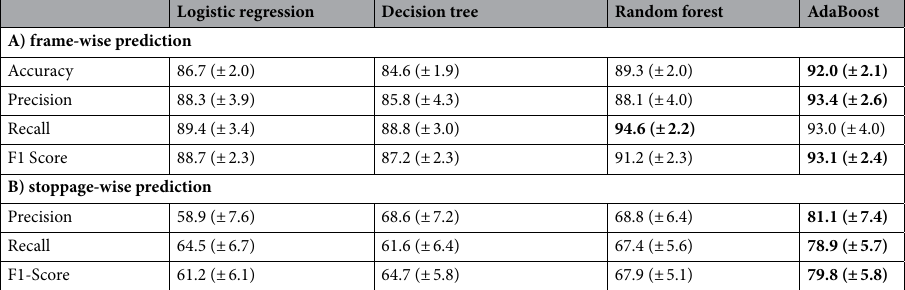
Table 1. Prediction results for A) frame-wise and B) stoppage-wise prediction of the four chosen ML models in 47 test matches. Accuracy, Precision, Recall, and F1-Score in percent with standard deviation. In B) only stoppages with a minimum duration of 2 s are considered. The best results are